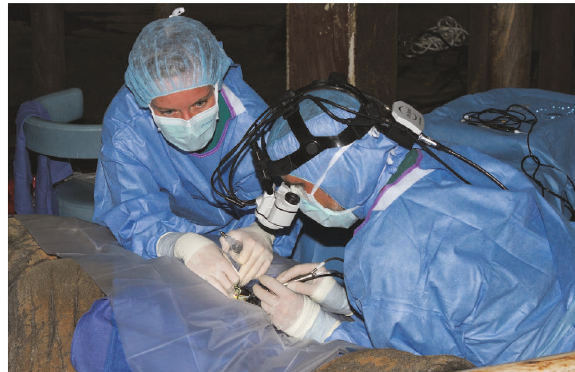
Figure 8: Due to the unconventional surgical location and position- ing of the elephant, a head-mounted microscope (Varioscope M5 (cid:3) , Acrivet, Veterinary Division of S&V Technologies AG, Hennigsdorf, Germany) was utilized to facilitate visualization for the